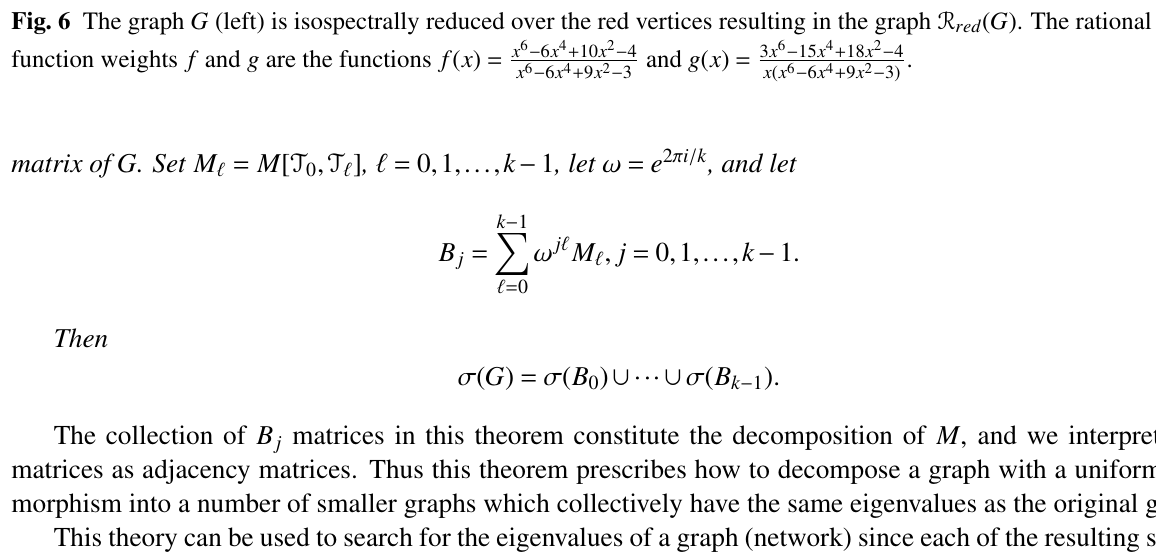
. and g ( x ) = 3 x 6 − 15 x 4 + 18 x 2 − 4 x 6 − 6 x 4 + 9 x 2 − 3 x ( x 6 − 6 x 4 + 9 x 2 − 3)